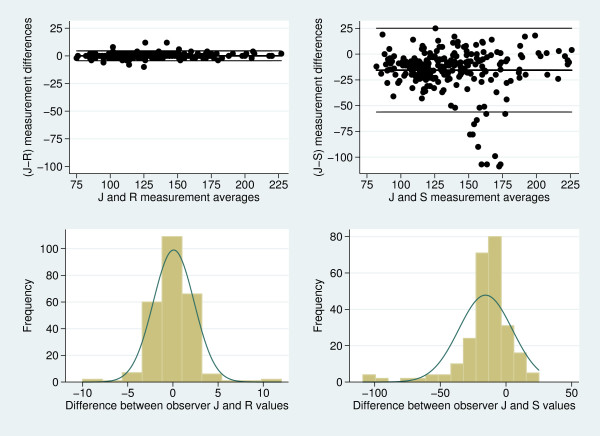
Scatter-plots of measurement differences against measurement averages with
the 95% limits of agreement superimposed (upper sub-plots) and histogram of
measurement differences (lower sub-plots) for pair-wise comparisons of
systolic blood pressure between the two observers (J & R), and between
observer J and the automated machine S (J & S). The 95% limits of
agreement appear in as the outer lines while the mean estimate of bias is given
by the intermediate lines in the upper sub-plots.